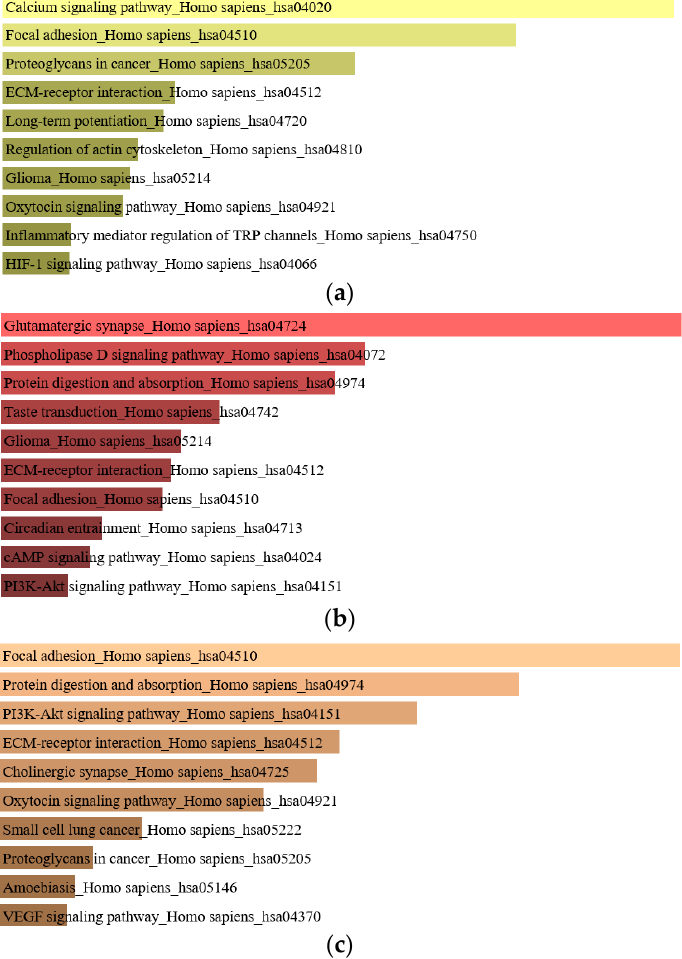
Figure 1. Enriched genes of ( a ) normal - colorectal adenoma, ( b ) normal colorectal cancer (CRC), and ( c ) the intersection of normal - colorectal adenoma and normal - CRC.